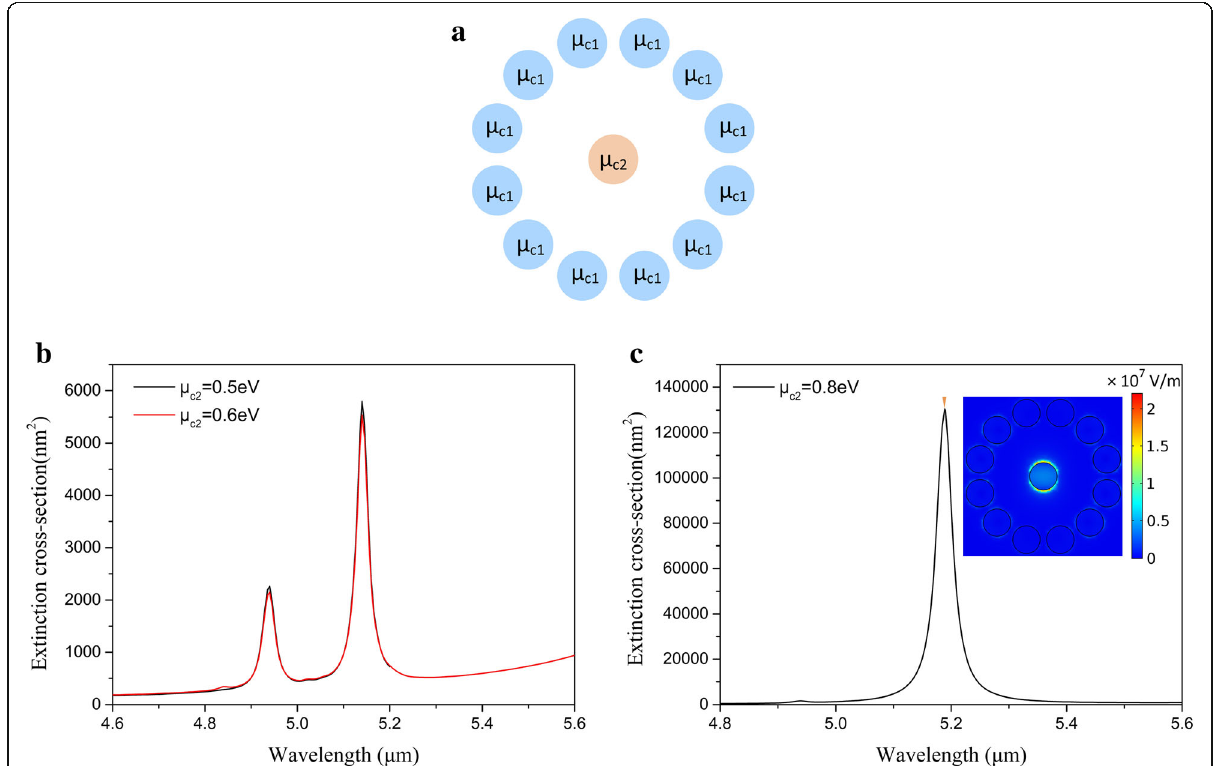
Fig. 5 a Schematic illustration of selectional graphene nanodisks with different chemical potentials to change chemical potential of central graphene nanodisk. b The extinction spectra of graphene oligomer with the chemical potential of central graphene nanodisk μ c 2 = 0.5eV and μ c 2 = 0.6eV. c The extinction spectrum of graphene oligomer with the chemical potential of central graphene nanodisk shows the electric fields (|E|) at the resonance